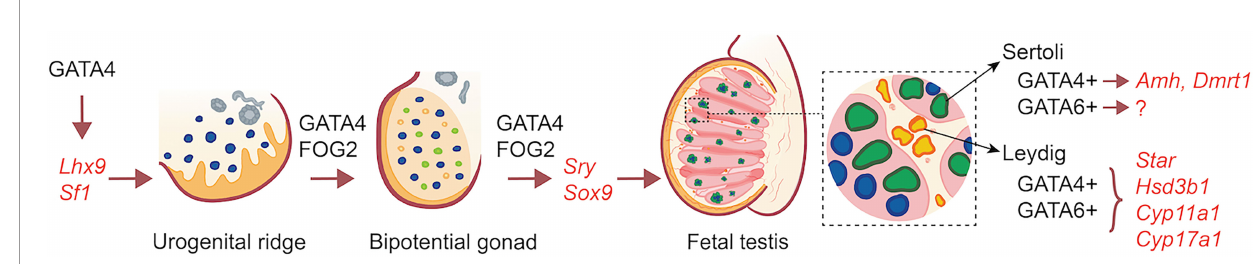
FIGURE 1 | Overview of the action of GATA factors in XY gonad development and fetal testis